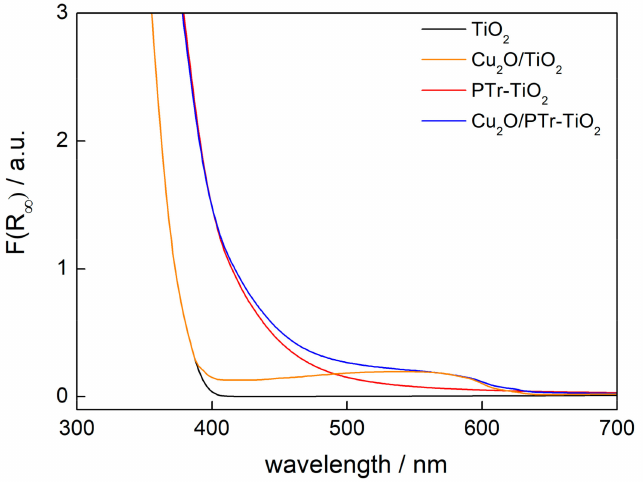
Figure 4. Diffuse reflectance spectra of TiO 2 , PTr–TiO 2 , Cu 2 O/PTr–TiO 2 . The Kubelka–Munk function F(R ∞ ) is equivalent to